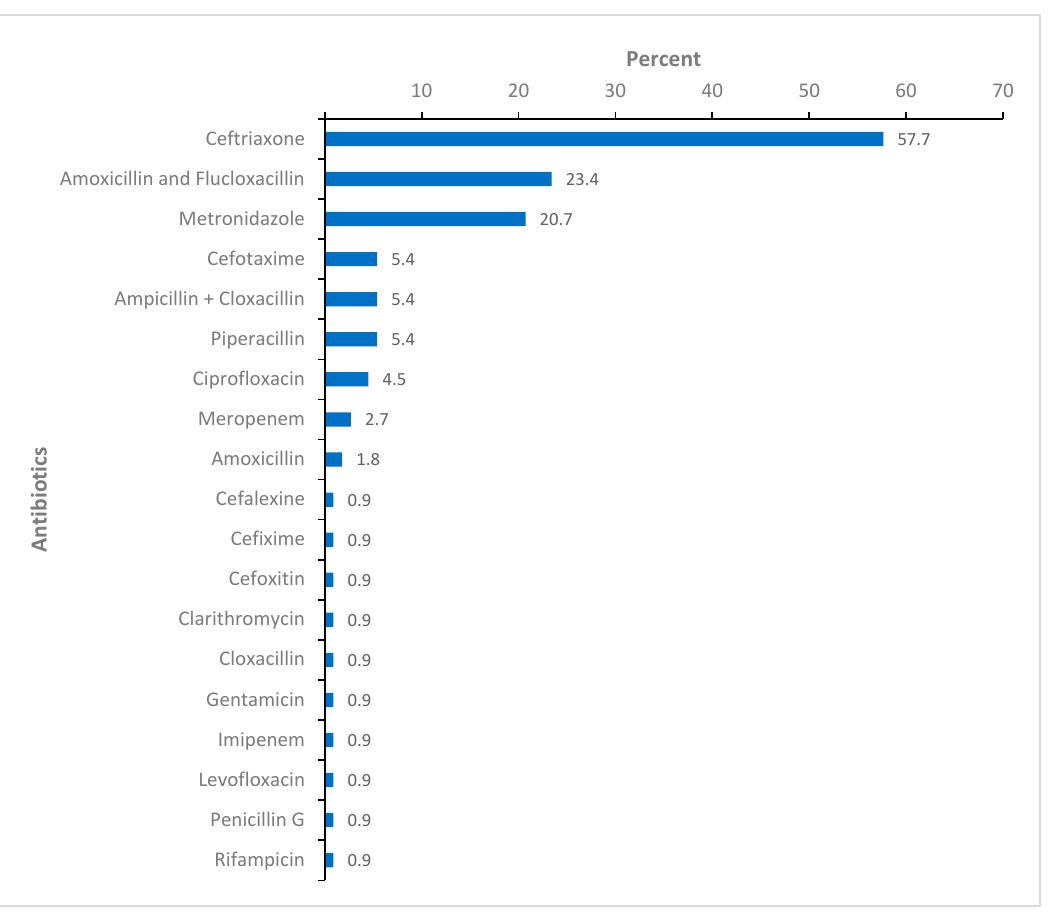
Figure 1. The antibiotic treatment at enrollment, n = 111. Figure legend: The percentage computed out of patients on antibiotic treatment at enrollment.